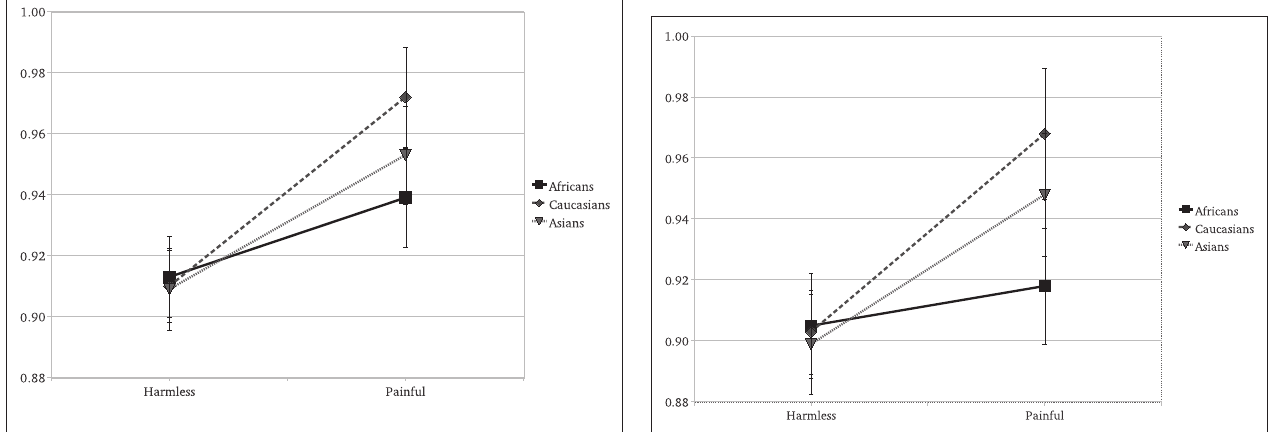
Figure 1 | experiment 1: mean SCr and standard errors as a function of stimulus type and actor’s race. Responses to pain were always greater than those to the harmless stimuli.